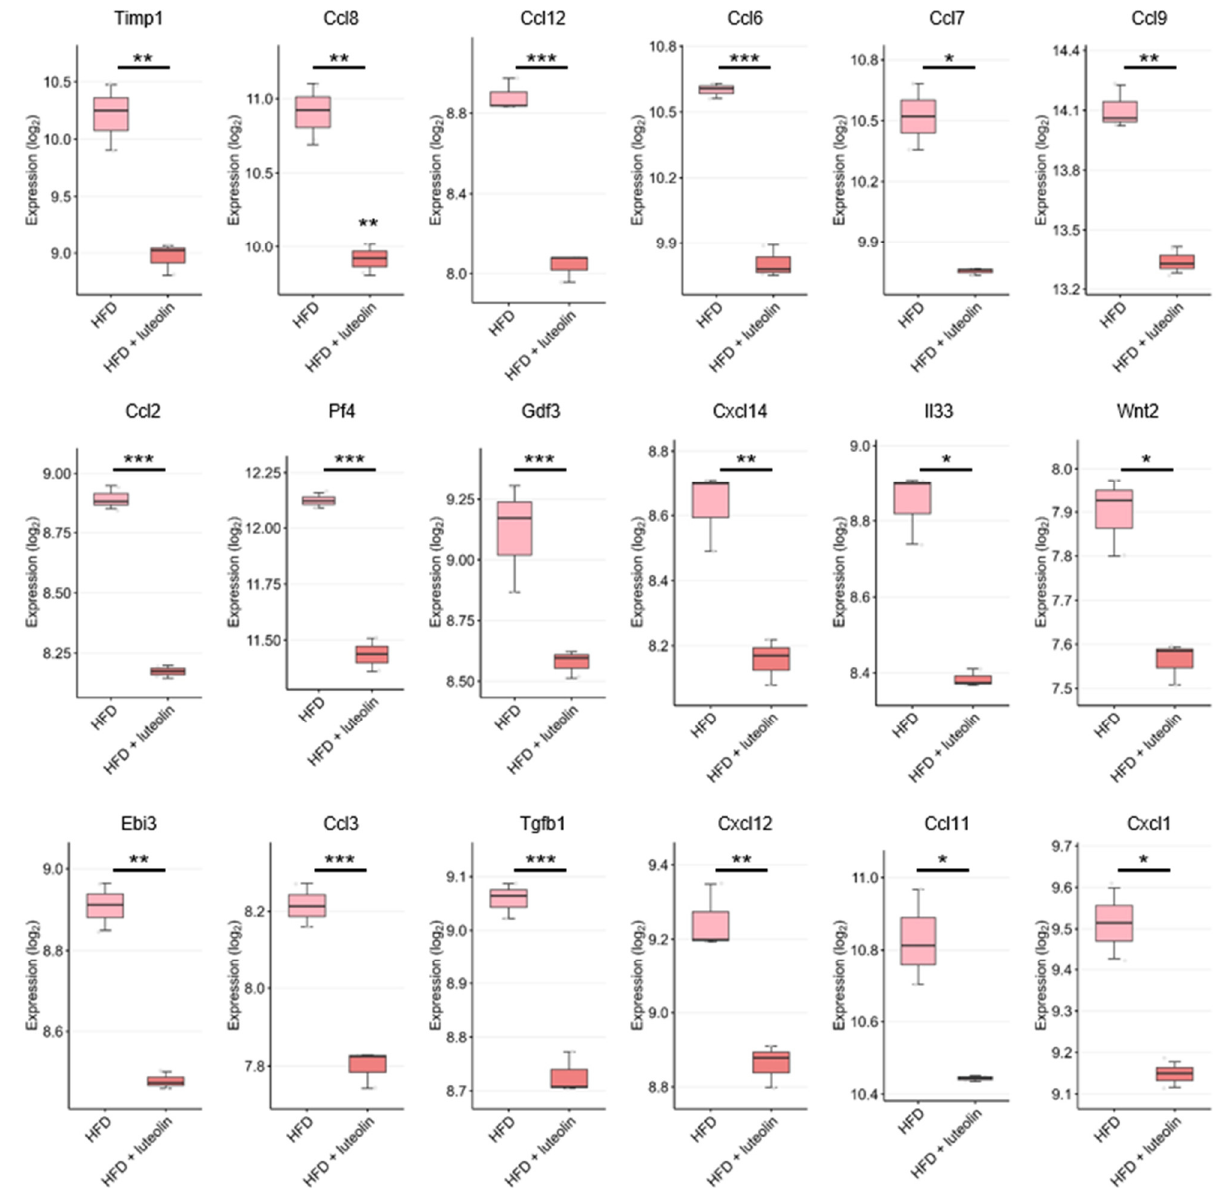
Figure 6. Comparison of Timp1, Ccl8, Ccl12, Ccl6, Ccl7, Ccl9, Ccl2, Pf4, Gdf3, Cxcl14, Il33, Wnt2, Ebi3, Ccl3, Tgfb1, Cxcl12, Ccl11, Cxcl1, Ccl21a, Bmp1, Ccl4, Ccl24, Nampt, Cmtm7, Il18, Areg, Gdf10, Clcf1, Tnfsf13b, Grn, Il7, Ccl21c, Gdf15, Edn1, Kitl, Ifng, Osm, Il1rn, Cxcl10 , and Cklf expression in mouse epididymal adipose tissue treated with HFD and with HFD and luteolin. The gene expression of each cytokine/chemokine was analyzed using the GSE111412 dataset. ***: p < 0.001, **: p < 0.01, and *: p < 0.05 compared to the induction group.